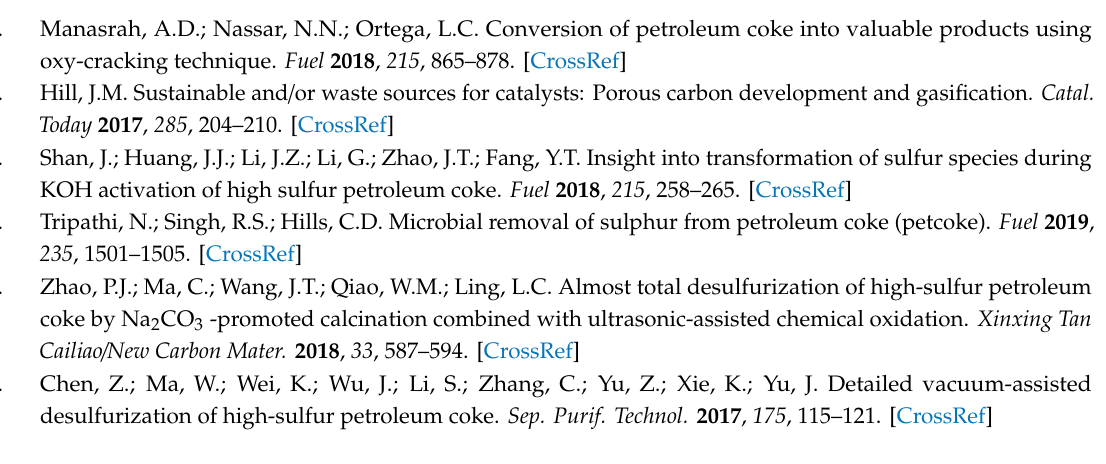
Figure S1: CO and CO 2 temperature-programmed decomposition profiles of petcoke samples before and after acid treatments. Figure S2: SEM images of (a) raw petcoke, (b) P-S-24, (c) P-N-24, and (d) P-N / S-24. Figure S3: Scheme of aromatic sulfonation with sulfuric acid treatment. Figure S4: Scheme of aromatic nitration with nitric acid